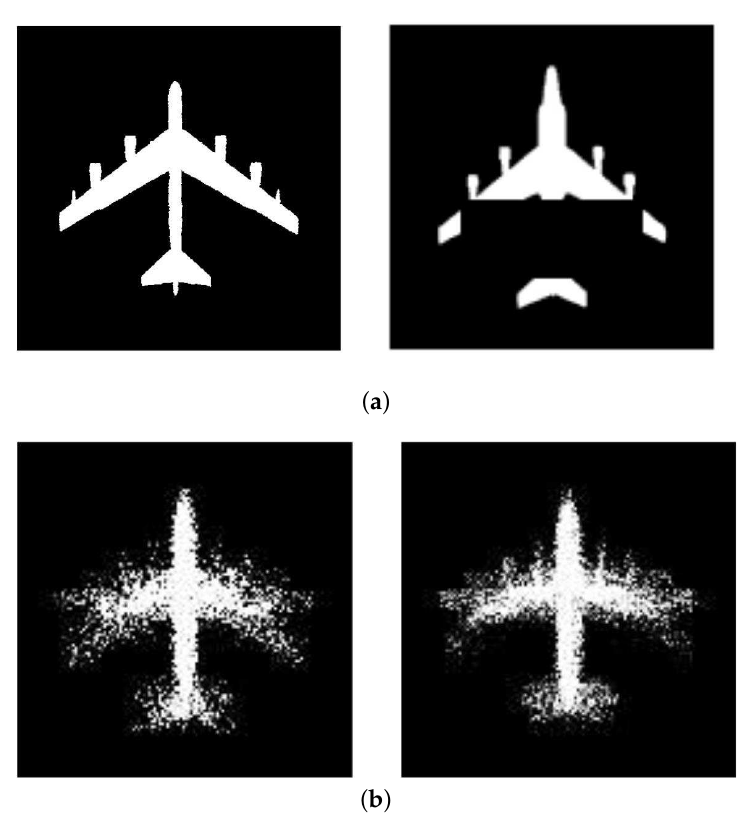
Figure 11. Results of shape prior modelling for objects without and with absent parts. ( a ) Input image; ( b ) Deep shape